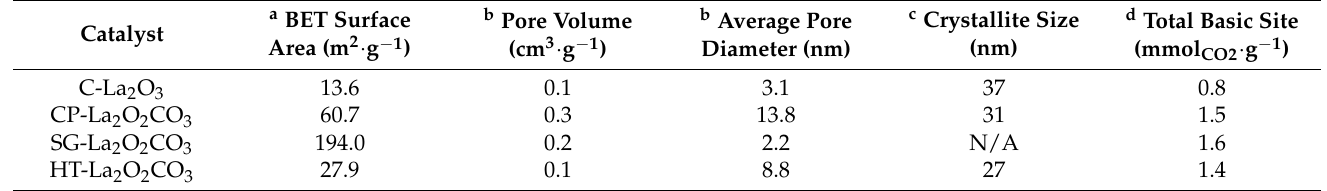
Table 1. BET surface area, pore volume, average pore diameter and total number of basic sites of the catalysts.